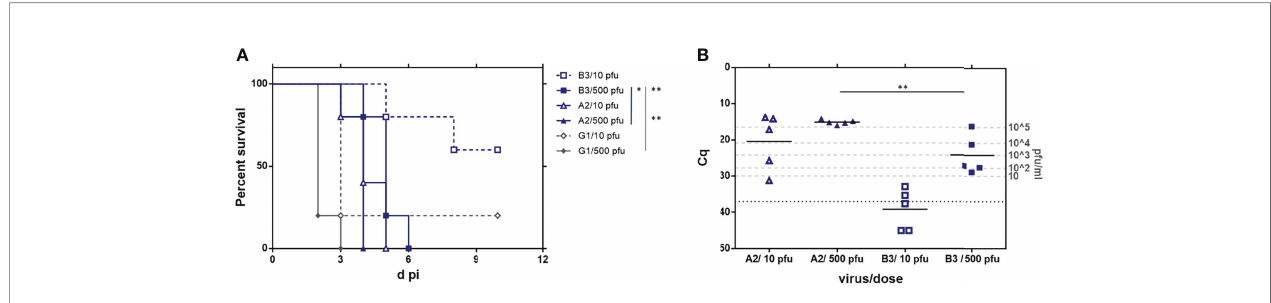
FIGURE 4 | Analysis of the in vivo pathogenicity of the rZH548-L mutant viruses in IFNAR KO mice. 15-week-old female mice (n = 5) were inoculated with 10 or 500 plaque-forming units (pfu) of the RVFVs rA2 and rB3. G1 (rZH548 D NSs::GFP) was included as reference control. (A) Survival rates. (B) Viremia determined by RT- qPCR on EDTA-blood samples collected at day 3 pi. Samples giving a Cq (quanti fi cation cycle) value under the detection level of the assay (37) are arbitrarily represented as 45. The correlation of Cq data with pfu equivalents (Moreno et al., 2020) is indicated in the right Y axis. Statistical analysis was only performed on results obtained from the groups inoculated with 500 pfu. The corresponding survival curves analyzed by log-rank (Mantel-Cox) rendered p values of p = 0.0047 (A2 vs G1); p = 0.0016 (B3 vs G1) and p = 0.0145 (A2 vs B3). *p < 0,05; **p < 0,005.